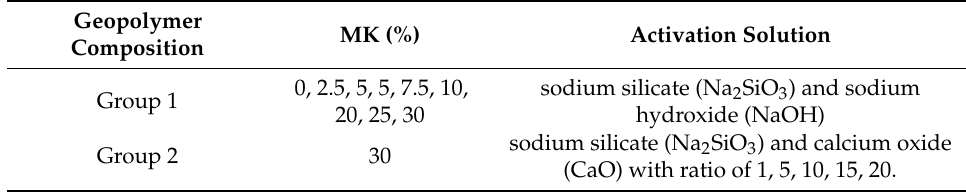
Table 2. The compositions of the geopolymer as a loess soil stabilizer used for the tensile strength test. Group 1: di ff erent MK content (%) with a constant activation solution of sodium silicate and NaOH. Group 2: di ff erent concentrations of CaO as a replacement to the NaOH in the activation solution with MK content of